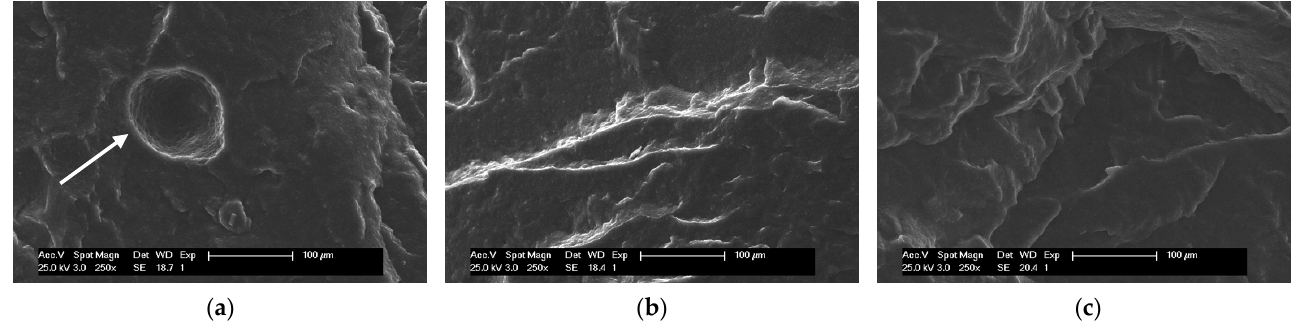
Figure 7. SEM photomicrograph of TPEs with A and ZnO: ( a ) A10Z2, ( b ) A10Z3, and ( c ) A10Z5. White arrow in ( a ) points to a space left by a bubble after vulcanization reaction.